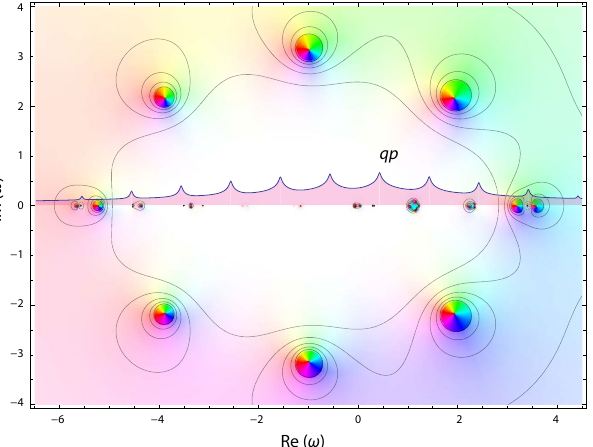
Figure 7. Electron Green’s function g β ( ω ) resolved in complex plane for Ω = 1, γ = 0.65 and n b = 1/2 computed using the forth order SE. Color coding as in Fig. 4. Exact spectral function is